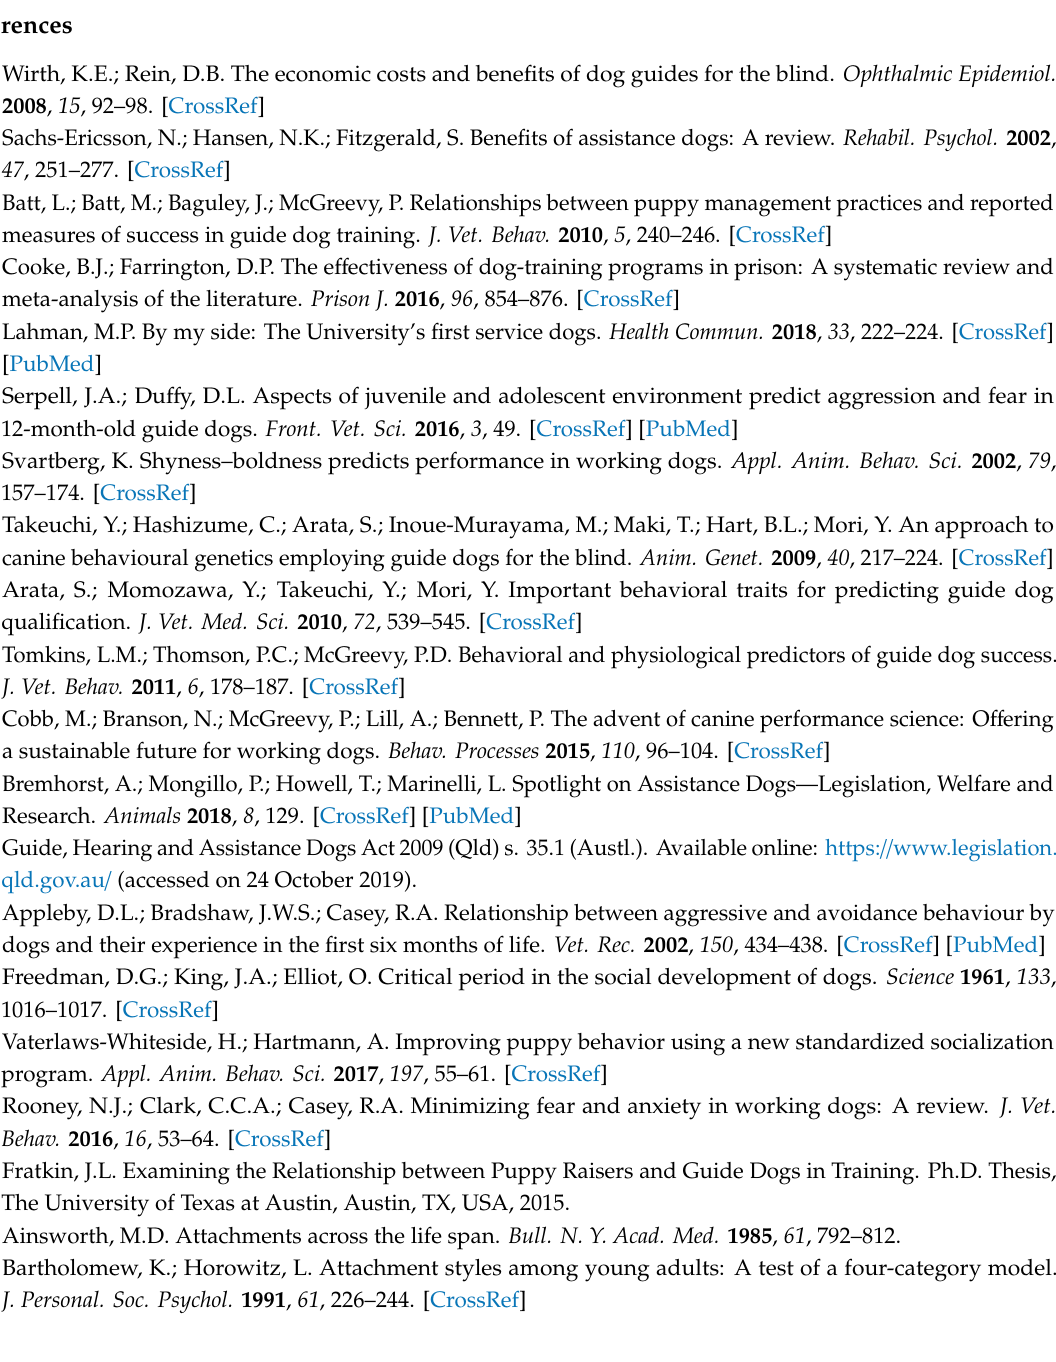
Table S1: Interview schedules for puppy raisers and sta ff